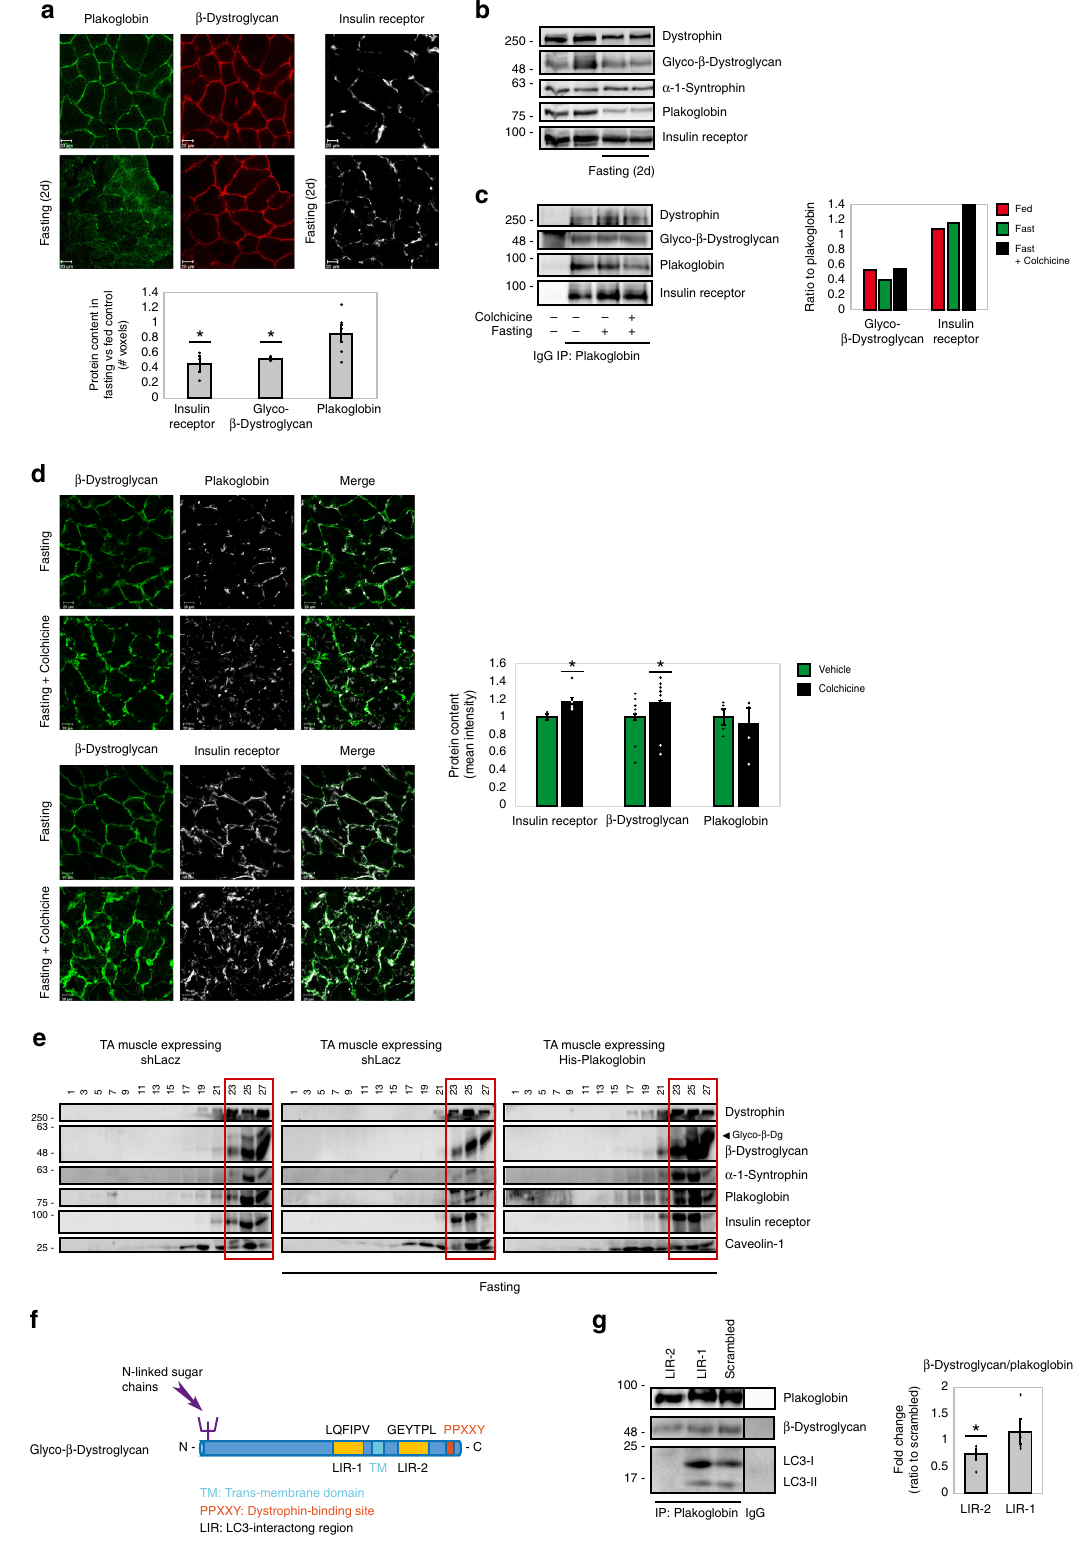
indicated by the depression of Pearson ’ s correlation coef fi cients (PCCs), as often occurs with overexpressed proteins) (Fig. 6h). Thus, under normal conditions, when plakoglobin-DGC-insulin receptor co-assembly is intact, plakoglobin seems to